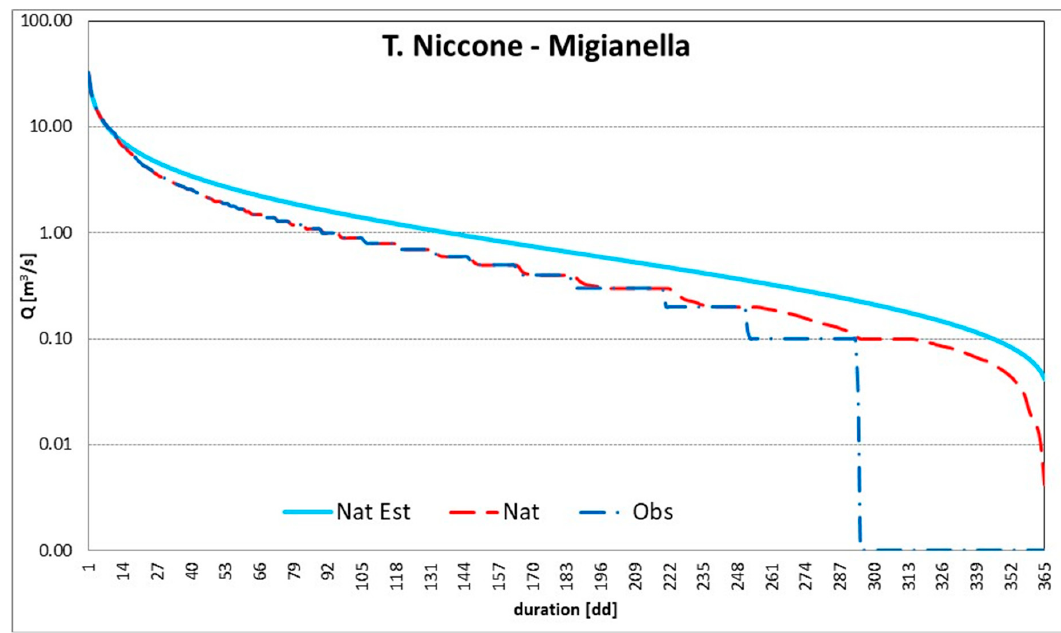
Figure 6. Average FDCs in the Migianella basin. Estimated natural FDC (Nat Est), natural FDC (Nat), and observed FDC (Obs).